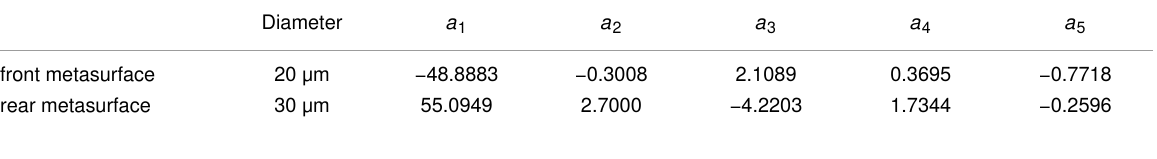
Table 1: Optimized phase coefficients of the front and back